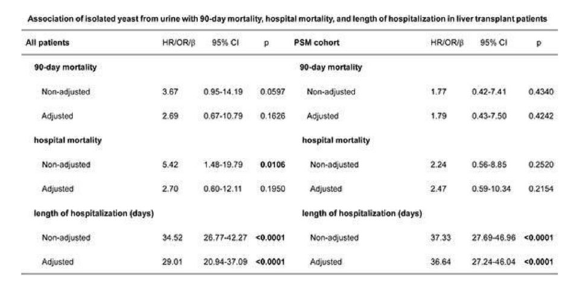
Table 1 (abstract 0354). Association of isolated yeast from urine with clinical outcomes of liver transplant